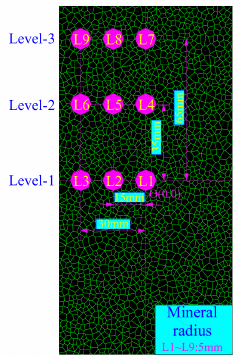
Figure 9. Mineral positions.